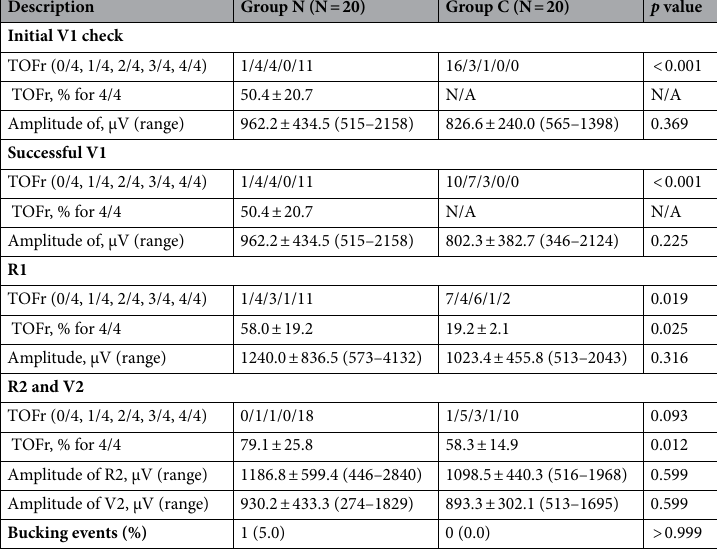
Table 3. Intraoperative neuromonitoring quality and outcomes. All data are presented as mean ± standard deviation, unless stated otherwise. TOFr train-of-four ratio, V1 initial electromyography signal of the vagus nerve before surgical dissection, RLN recurrent laryngeal nerve, R1 initial electromyography signal of the recurrent laryngeal nerve at its initial identification, R2 electromyography signal of the recurrent laryngeal nerve after thyroidectomy, V2 electromyography signal of the vagus nerve after